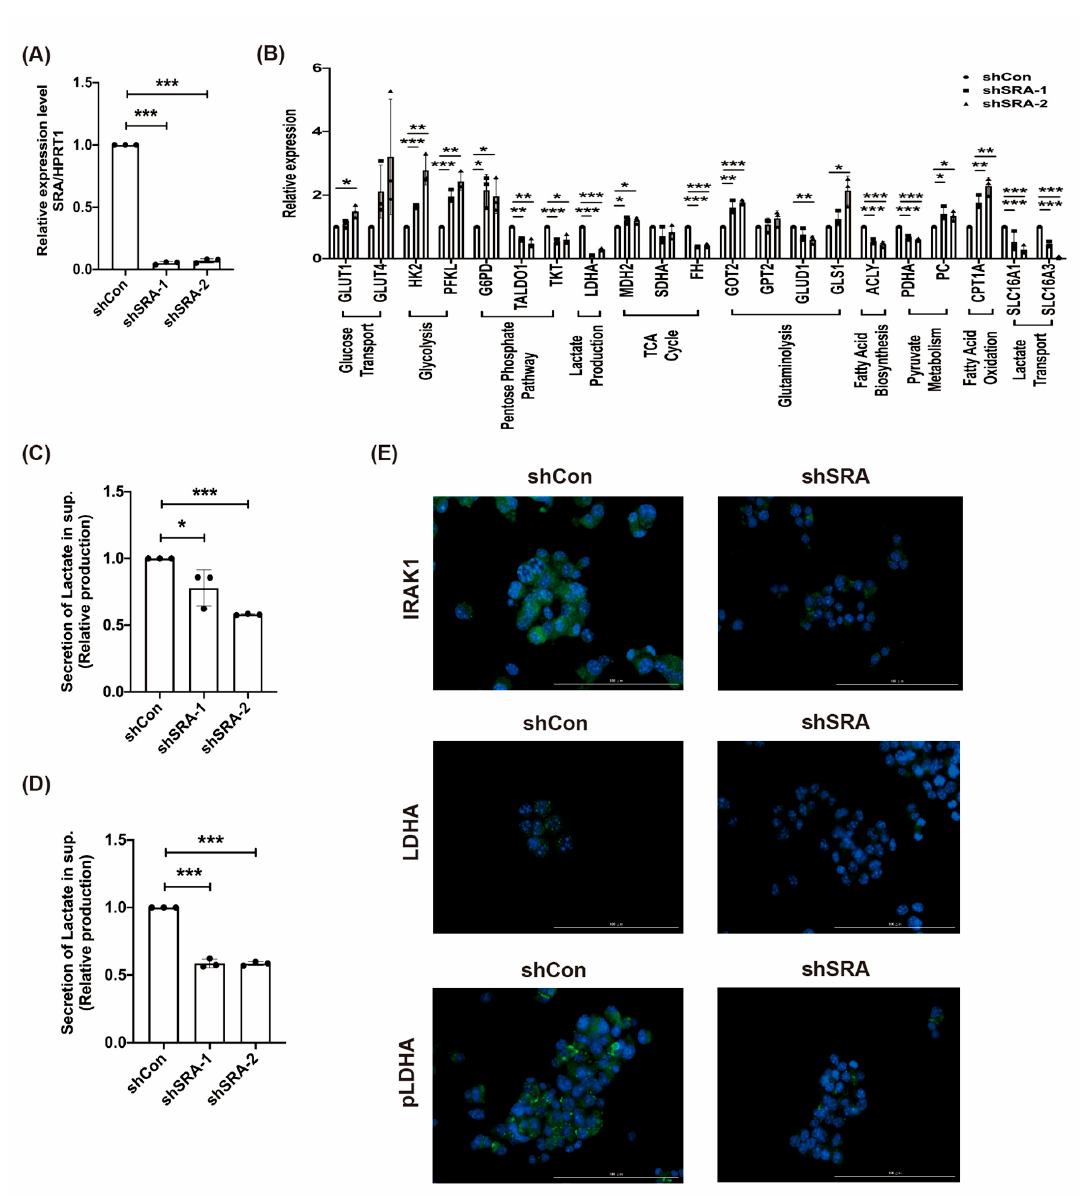
Figure 4. lncRNA SRA induces MIN6 β -cell metabolic reprogramming and the IRAK1/lactate dehydrogenase A (LDHA)/phosphorylated LDHA (pLDHA) signaling pathway. ( A ) lncRNA SRA expression analysis of MIN6 β -cells (shCon and shSRA). ( B ) mRNA expression analysis of metabolic genes after knockdown with lncRNA SRA (shCon and shSRA). Lactate was analyzed by mass spectrometry (MS) ( C ) or a luminescence-based kit ( D ) in MIN6 β -cells after knockdown lncRNA SRA (shCon and shSRA). Representative immunofluorescence images of shCon and shSRA MIN6 β -cells. Co-staining for ( E ) IRAK1, LDHA, or phosphorylation of LDHA (Tyr10) (green) with DAPI (blue). Scale bar, 100 µ m. Mean ± SD, Student’s t -test (unpaired, two-sided). * p < 0.05, ** p < 0.01, *** p <